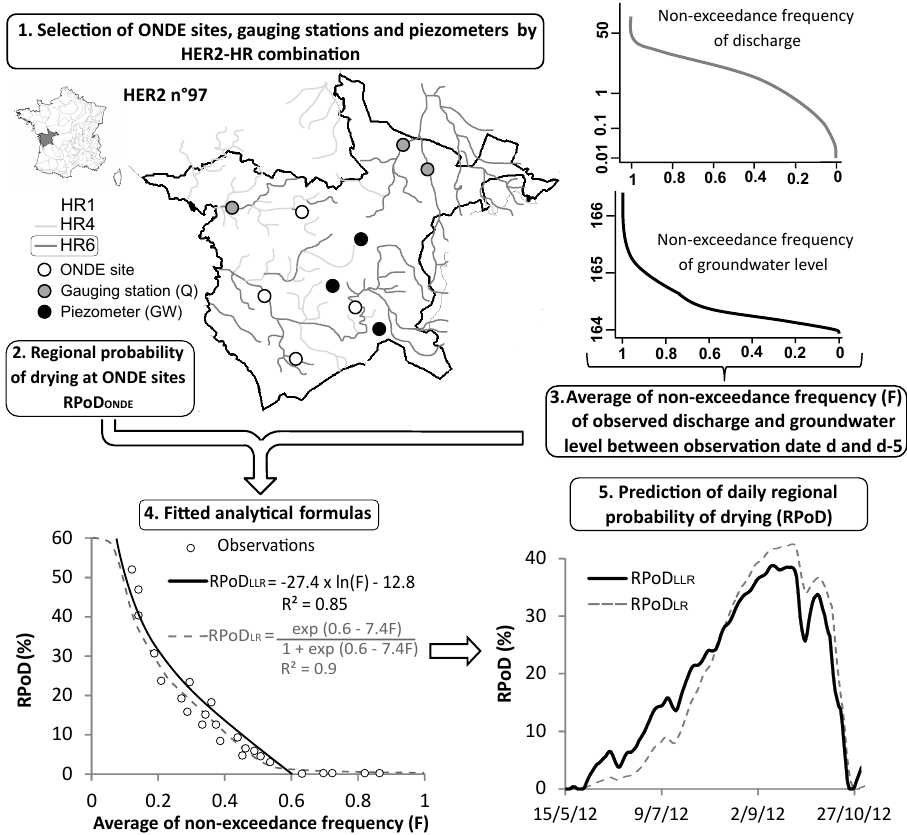
Figure 3. Strategy of parametric modelling (steps 1–4) developed to predict (step 5) the regional probability of drying (RPoD) by HER2–HR combination in